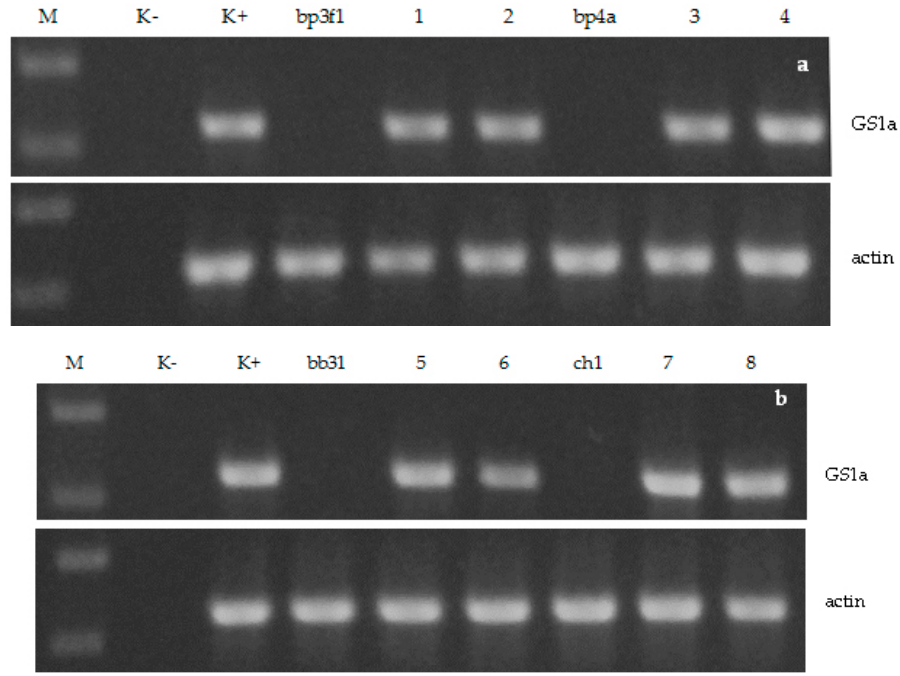
Figure 1. RT-PCR analysis of the GS1a gene expression in B. pubescens ( a ) and B. pendula ( b ) plants. The actin gene was used as an endogenous control. M—markers (750 and 500 bp); K-—water; K+—pGS (for the GS1a gene) or non-transgenic birch plants (bp3f1 or bb31 for the actin gene); bp3f1, bp4a, bb31, ch1—wild-type plants; 1—F14GS8b; 2—F14GS9b; 3—P9GS18b; 4—P17GS1a, 5—B29GS1; 6—B29GS4; 7—N18GS8a; N18GS8b.